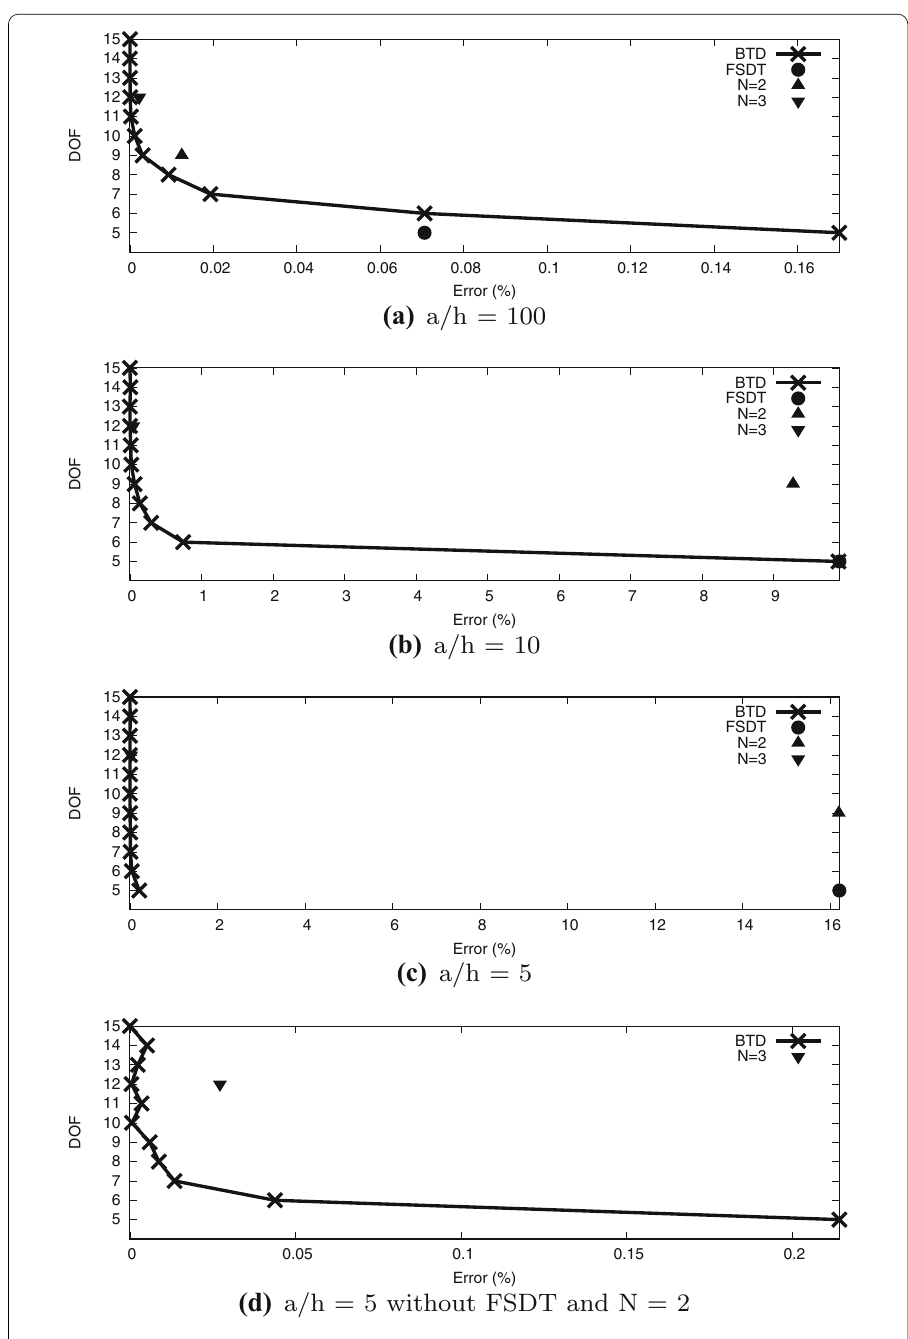
Fig. 5 BTD for 0/90/0, R/a = 2